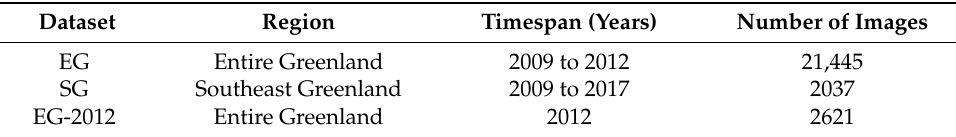
Table 1. Datasets and their